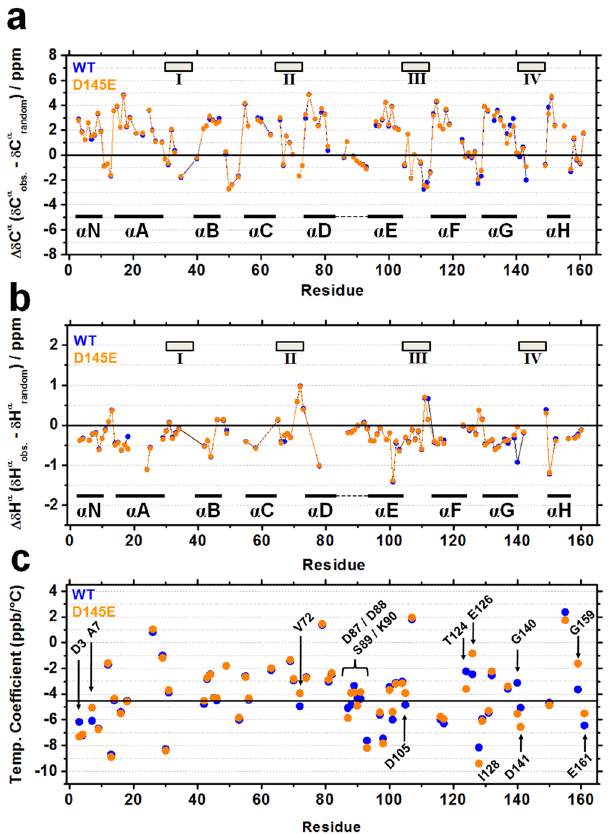
Figure 3. Secondary structure at 25 °C ( a , b ) and distribution of amide hydrogen temperature coefficients over the range 15°–55 °C ( c ) among WT ( ) and D145E ( ) residues. Deviation of experimental (obs.) chemical shifts ( δ ) from random coils for backbone C α (a) and H α ( b ). Random-coil chemical shift values were obtained from ref. 27. Rectangles (I–IV) and black line segments ( α N, α A, etc) identify Ca 2 + -binding sites and α -helices known to be present in WT cTnC. Alpha-helical segments show positive deviations for C α and negative deviations for H α , while β -strands and loops show the opposite. Dashed lines between α -D and α -E in a and b represent the D/E linker region. In ( c ), amide hydrogens with temperature coefficients that were linear but very different ( > 95% C.I.) for WT and mutant proteins are identified by residue. Temperature coefficients of the protons coincide (or differ only slightly) for the two isoforms except where one of the paired values is labeled with an